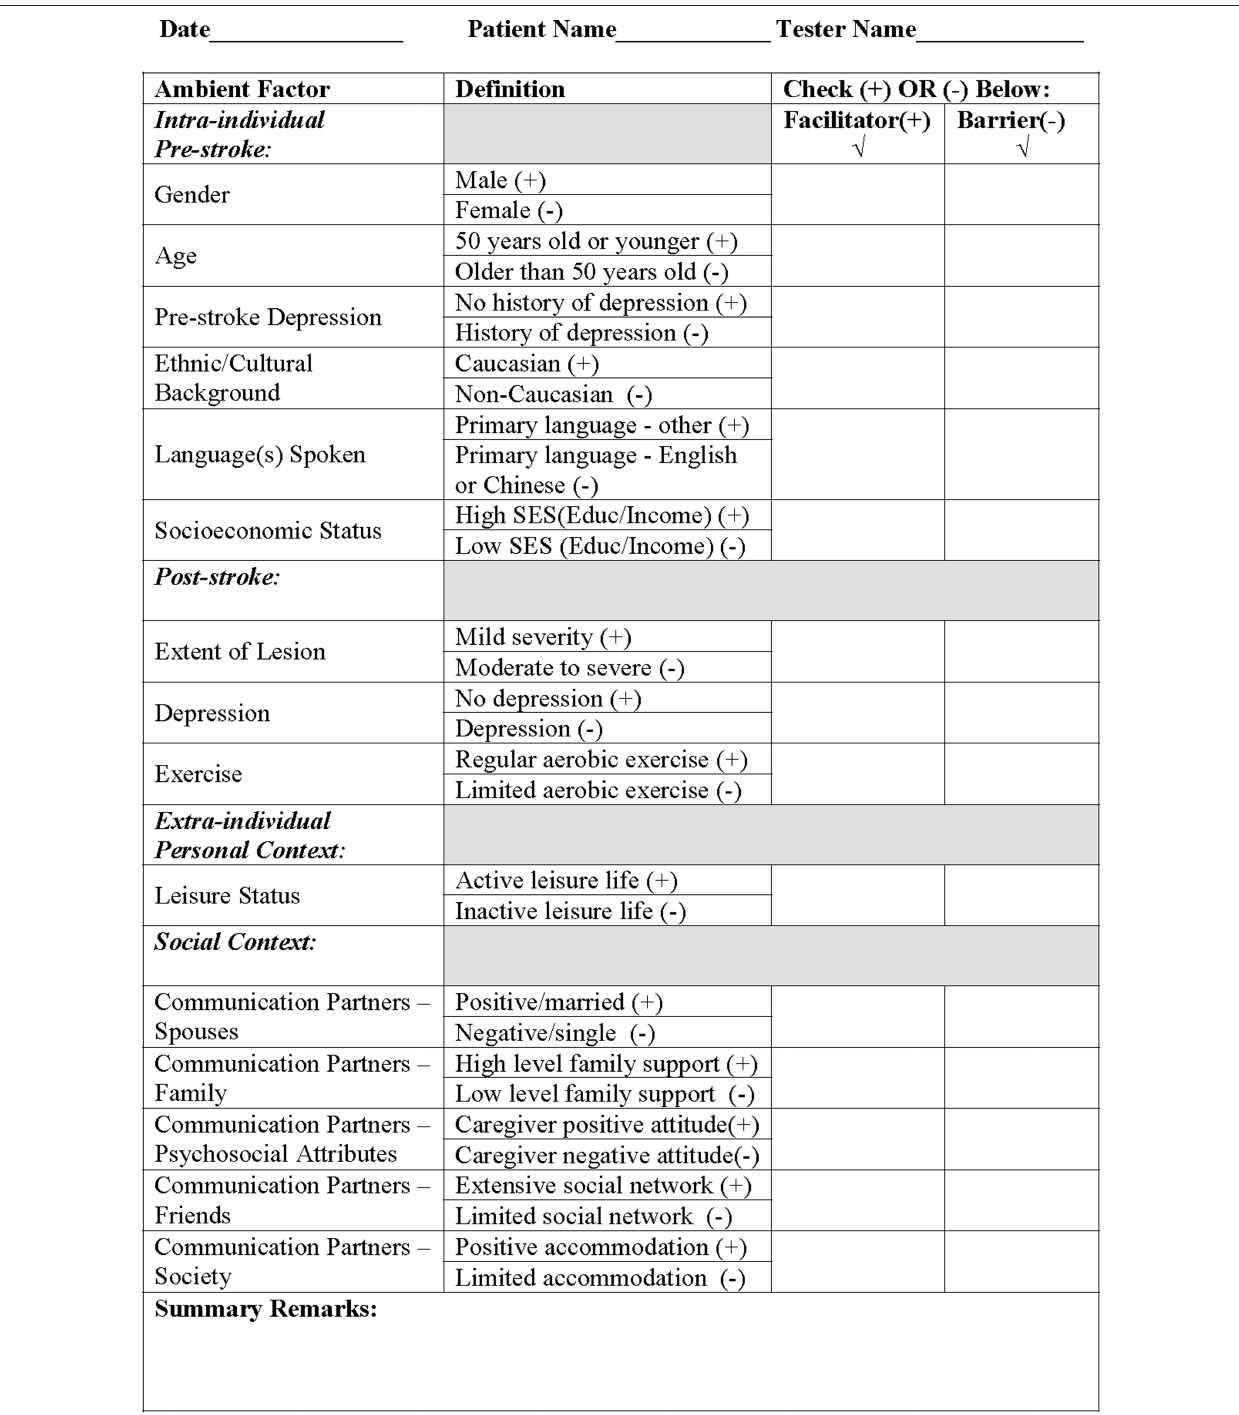
Status, into the treatment environment has the potential for fusing ambient and therapeutic experience with attendant benefits for communicative